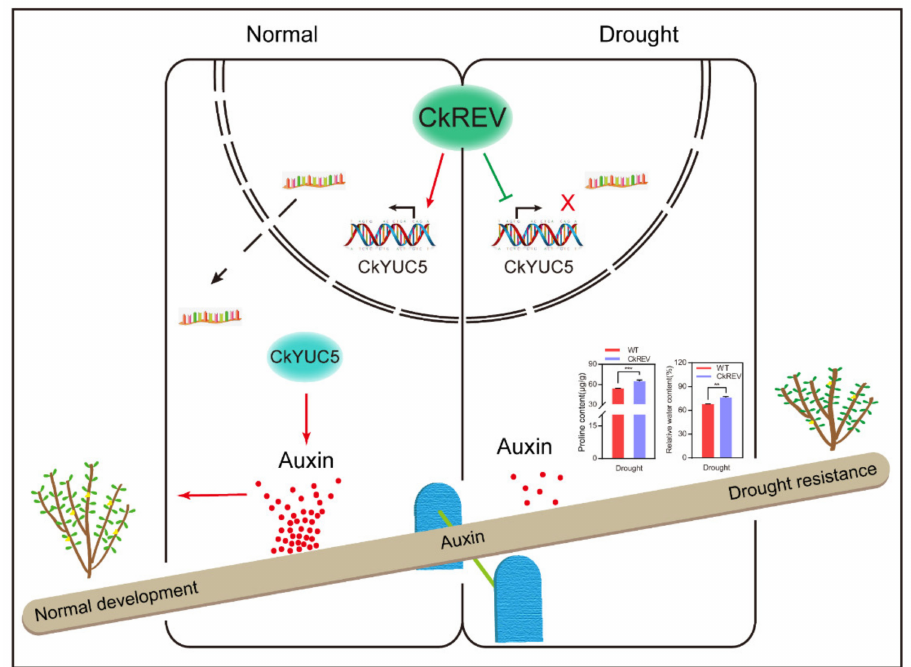
Figure 8. Model of regulation of CkREV on the expression of CkYUC5 . The model concludes our research and exhibits that CkREV bidirectionally regulates the expression of CkYUC5 critical in auxin synthesis depending on changes in external environmental signals, balancing the growth and drought-resistance of plants by influencing auxin